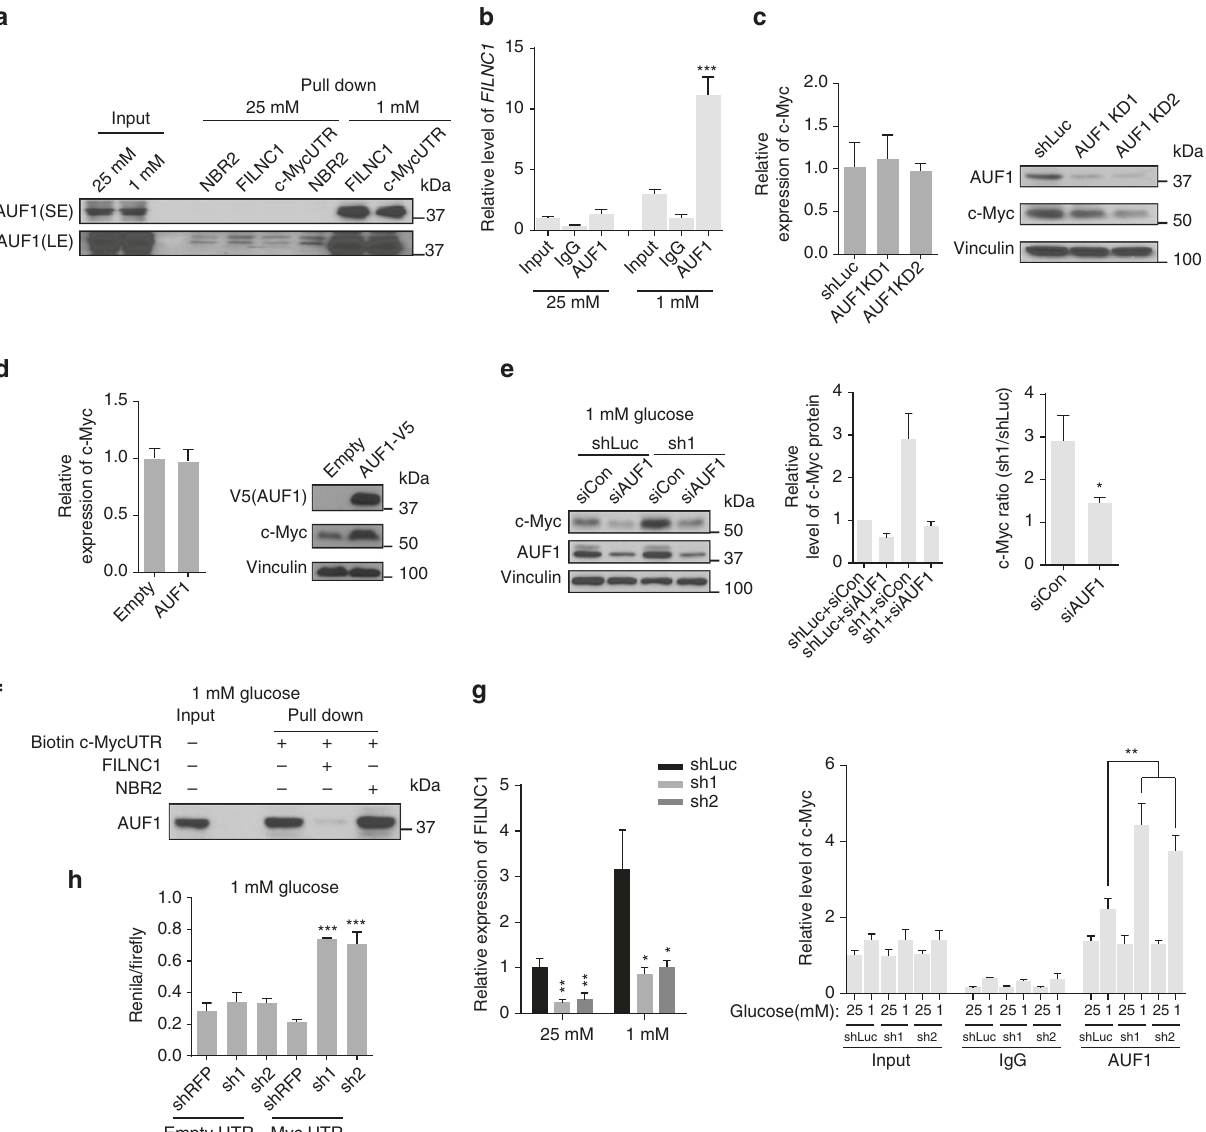
Fig. 5 FILNC1 interacts with AUF1 and sequesters AUF1 from binding to c-Myc mRNA. a In vitro-synthesized biotinylated NBR2 , FILNC1 , and c-Myc 3 ʹ UTR were incubated with whole-cell lysates from 786-O treated with indicated conditions for 24 h. Precipitation reactions were conducted with streptavidin beads, and then subjected to western blotting analysis for AUF1. b Whole-cell lysates from 786-O cells treated with indicated conditions for 24 h were immunoprecipitated with AUF1 antibody or IgG. The levels of FILNC1 in the precipitates were measured by real-time PCR. c , d Real-time PCR to measure the mRNA levels of c-Myc ( left panel ), and western blotting to measure c-Myc protein level ( right panel ) in 786-O cells infected with AUF1 shRNAs ( c ) or with AUF1 cDNA overexpression ( d ). e 786-O cells with AUF1 and FILNC1 single or double knockdown were cultured in 1 mM glucose-containing medium for 24 h. Whole-cell lysates were collected and subjected for western blotting as indicated. The quantitation of the c-Myc western Blot signal from triplicate experiments and the corresponding ratios were shown as bar graphs ( middle and right panels respectively). f In vitro-synthesized biotinylated c-Myc 3 ʹ UTR were incubated with cell lysates from 786-O cells that had been cultured in 1 mM glucose-containing medium for 24 h. Non-biotinylated FILNC1 or NBR2 was used as a competitor in precipitation reactions. After precipitation with streptavidin beads, samples were subjected to western blotting for AUF1. g 786-O control or FILNC1 knockdown (sh1 and sh2) cells treated with indicated conditions for 24 h were subjected to detect FILNC1 expression using real-time PCR ( left panel ), or were immunoprecipitated with AUF1 antibody or IgG ( right panel ). The levels of c-Myc mRNA in the precipitates were measured by real-time PCR. h Luciferase activity of a reporter fused to a c-Myc or empty 3 ′ UTR in 786-O cells treated with indicated conditions for 24 h. Values represent mean ± s.d. from three independent experiments, two-tailed Student ’ s t -test. * P < 0.05; ** P < 0.01; *** P <